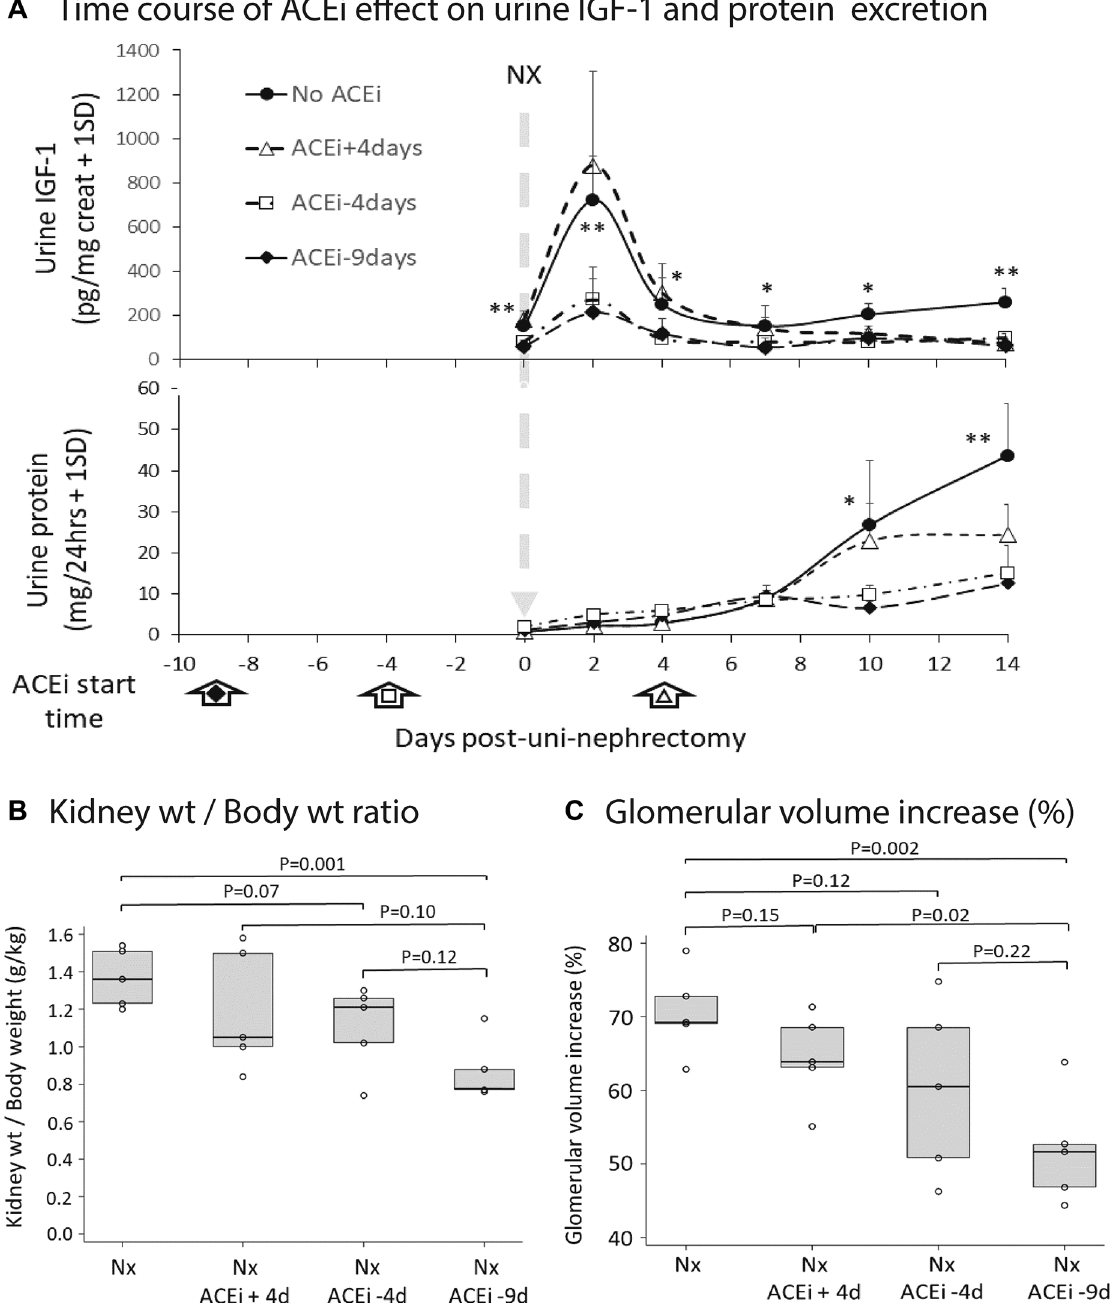
Figure 4. Short-term time-course post-uni-Nx showing the effect of ACEi started either 4 days after uni- nephrectomy or 4 or 9 days before uni-nephrectomy. Panel ( A ) Upper Panel. Effect of ACEi timing on urine GF-1 excretion. ACEi (enalapril 10 mg/kg/day in drinking water) was started 9 days before uni-Nx (solid triangles) or 4 days before uni-Nx (open squares) significantly reduced the baseline IGF-1 excretion, the 2-day IGF-1 peak of urine IGF-1 following uni-Nx, and urine IGF-1 excretion remained lower than control non-ACEi-treated rats by day-14. If ACEi was started 4-days post-uni-Nx, the 2-day urine peak was preserved, but by day-14, the urine IGF-1 had decreased to levels similar to the ACEi pre-Nx treated groups. N = 5 per group. * P < 0.05, ** P < 0.01. Panel ( A ) Lower Panel. Effect of ACEi timing on 24 h urine protein. Urine protein excretion in non-ACEi-treated rats did not increase significantly following uni-Nx until day-10 and 14. ACEi pre-treatment significantly reduced urine protein at day-10 and 14 post-uni-Nx. By day-2 following uni-Nx, when IGF-1 had increased 8-fold, urine protein excretion was not increased. Panel ( B ) Effect of ACEi pre-treatment on the kidney weight/body weight ratio by day-14 post-uni-Nx. Panel ( C ) Effect of ACEi pre-treatment on the glomerular volume by day-14 post- uni-Nx. Kidney weight/body weight ratio and glomerular volume increase were significantly reduced compared to the non-ACEi-treated group by ACEi started 9-days before uni-Nx. ACEi started 4-days before uni-Nx did not reach statistical significance. The error bars are 1SD. * P < 0.05, ** P <